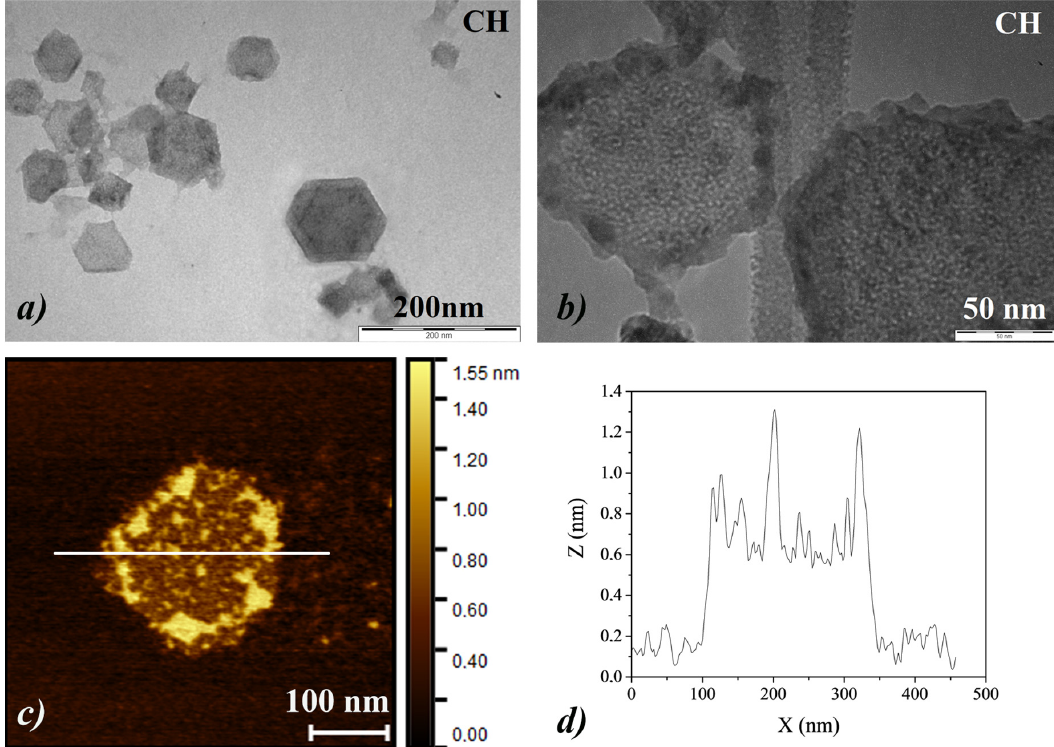
Figure 5. ( a , b ) Transmission Electron Microscopy (TEM) images of CH nanoparticles, acquired at different magnifications; ( c , d ) Atomic Force Microscopy (AFM) image of CH nanoparticles together with the corresponding profile analysis along the Z -axis of the primary nanoparticles (NPs) .